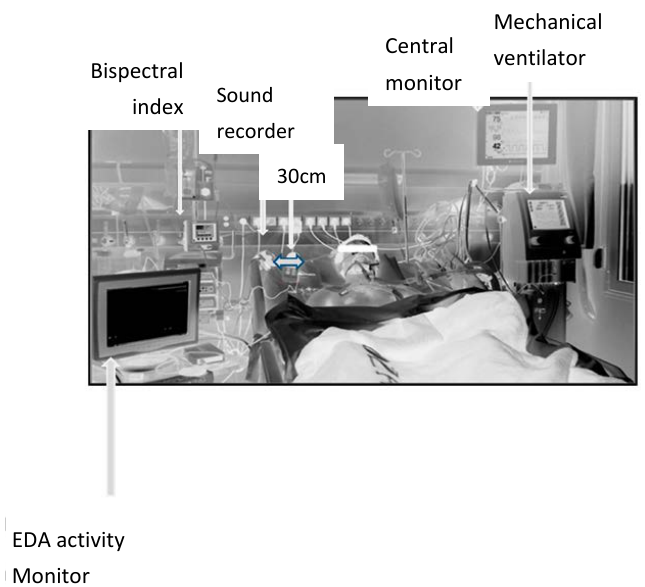
Figure 1. Arrangement of recordings devices during the observation period.